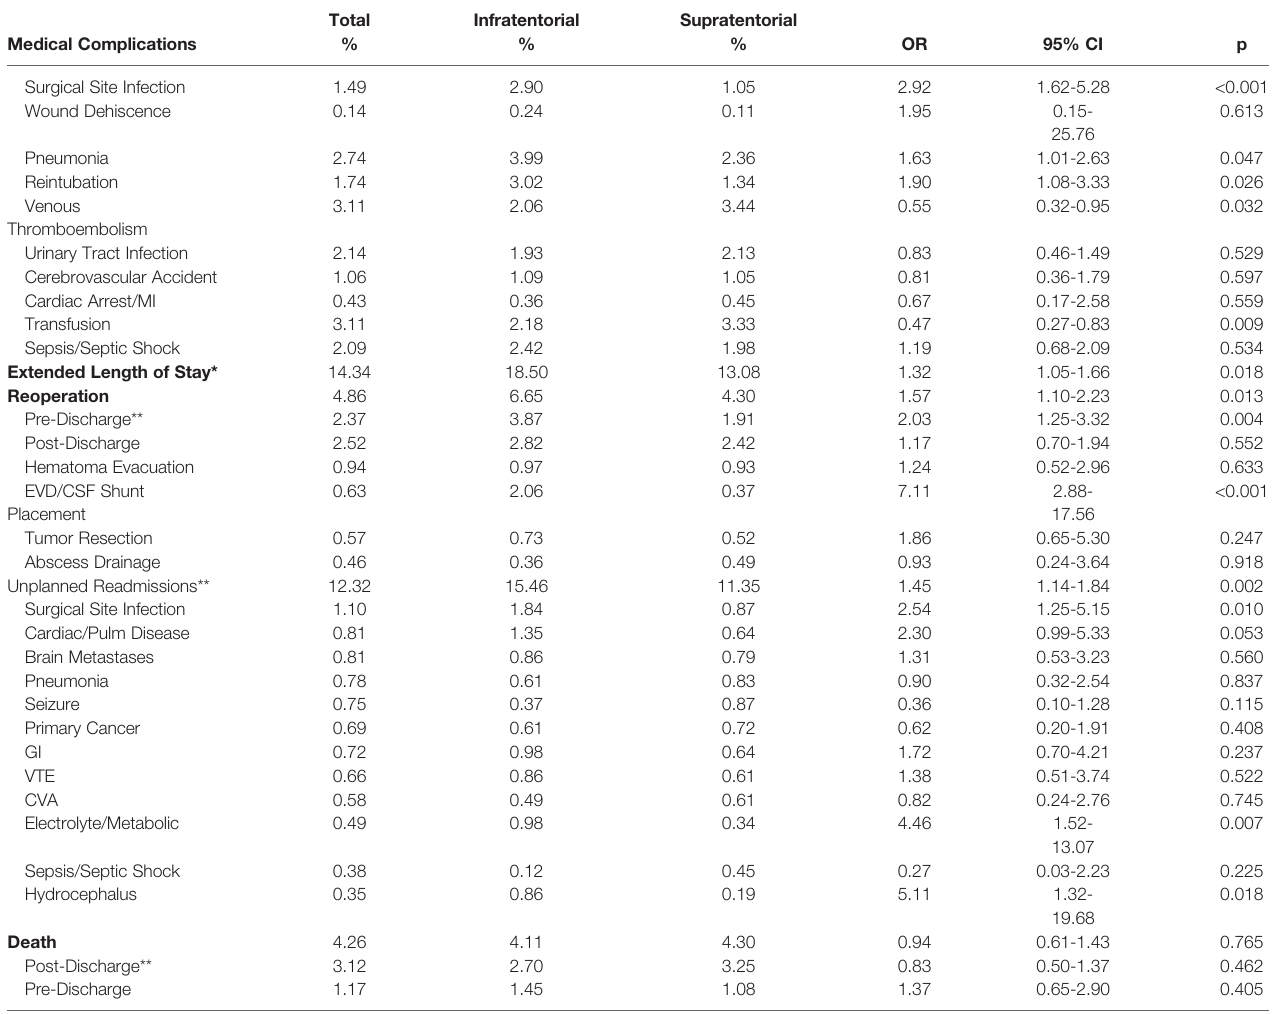
TABLE 3 | Adjusted association of infratentorial approach with 30-day postoperative complications.